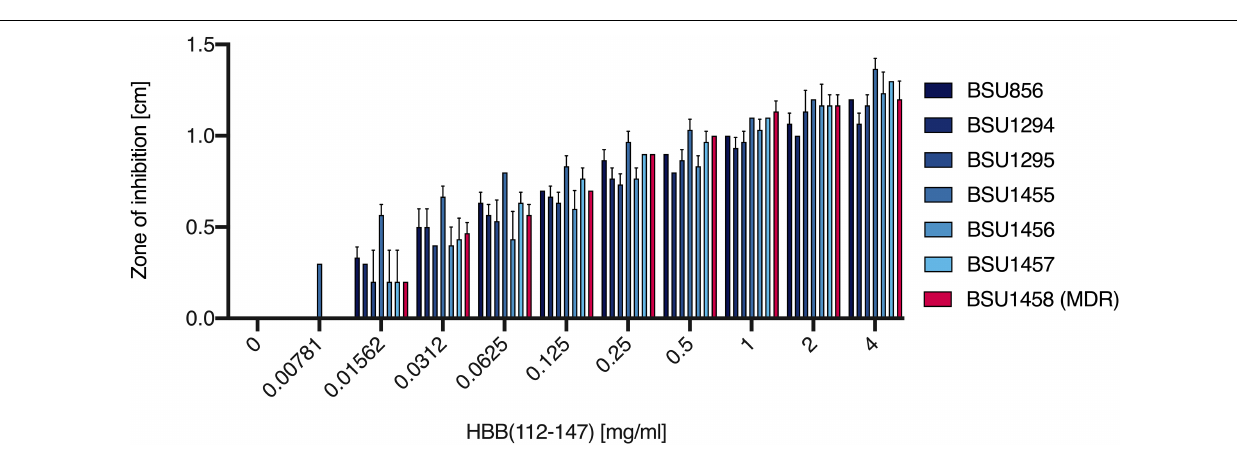
resuspended to an OD of 0.1 and adjusted to pH values of